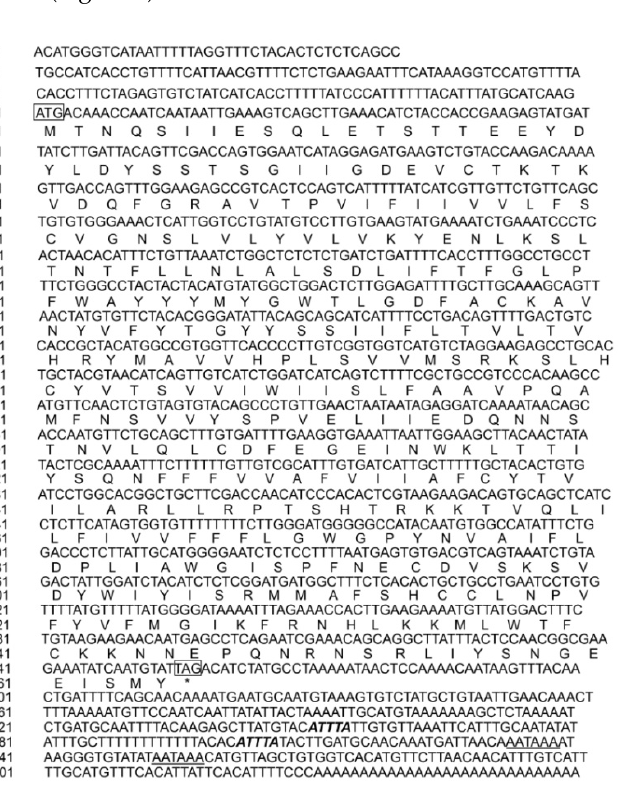
Figure 1. The full-length cDNA sequence of Ctenopharynodon idellus XCR1 . The initiation codon “ATG” and the termination codon “TAG” are labeled by square frame; the termination signal is labeled by “*”; the mRNA tailing signal is labeled by italic and bold; and the mRNA instability motif is labeled by underline.